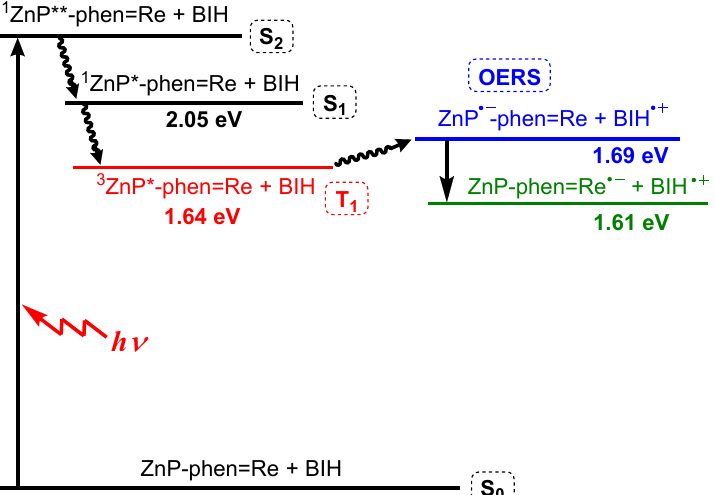
Figure 10. Energy diagram of ZnP-phen=Re and BIH in DMA [43]. The double asterisk indicates the higher excited state.